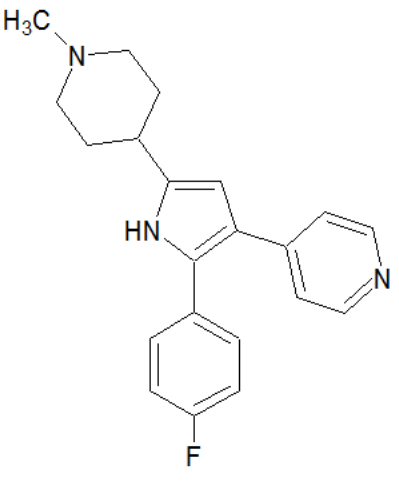
Figure 6. Chemical structure and name of the coccidian PKG inhibitor inhibitor 1,